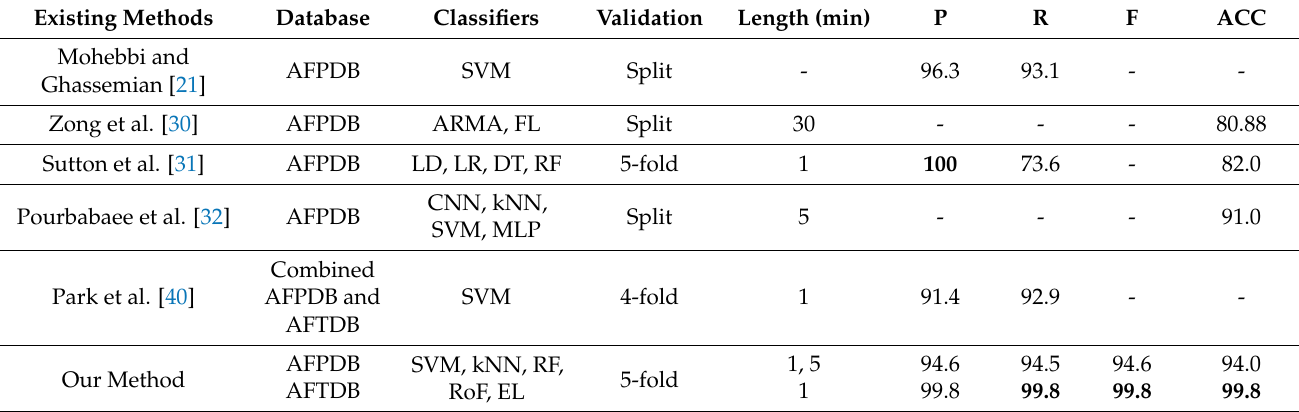
Figure 10. The wearable T-shirt (Pro-Kit, Hexoskin, Quebec, Canada) ( a ), the cECG chair (Smart Seat, Capical, Braunschweig, Germany) ( d ), the acquired one-minute ECG segments from these sensors ( b , e ), and the corresponding transition pattern evaluated using our method ( c , f ), respectively. Table 8. Comparison of the state-of-the-art methods with our approach. Bold values indicate the best performance in a